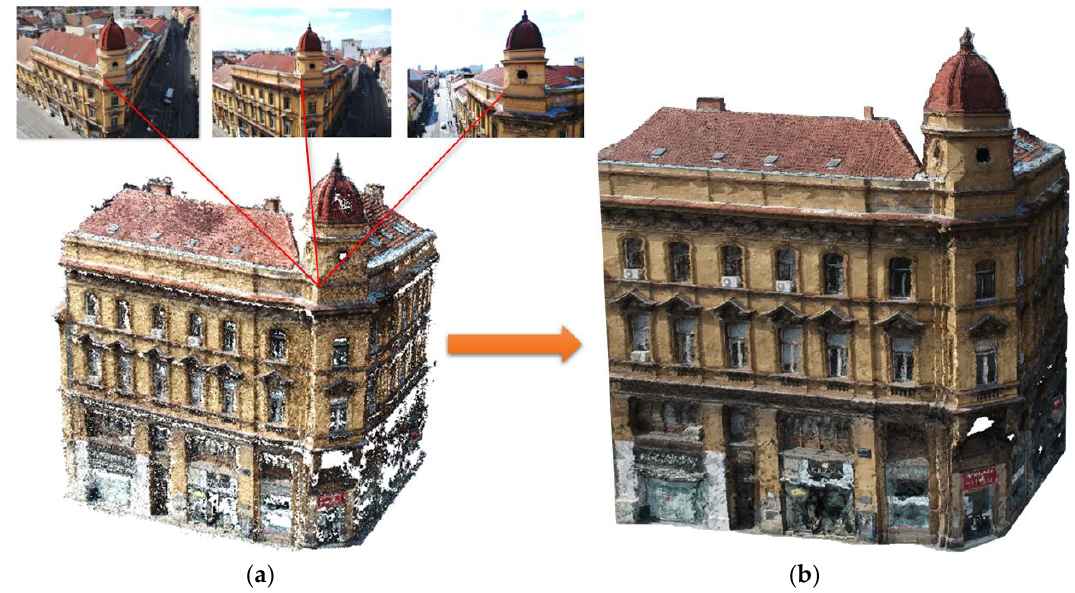
Figure 2. Photogrammetric 3D building modeling methods. From ( a ) photogrammetric creation of SfM (Structure-from-motion) point clouds to the ( b ) high-resolution photorealistic 3D building model.